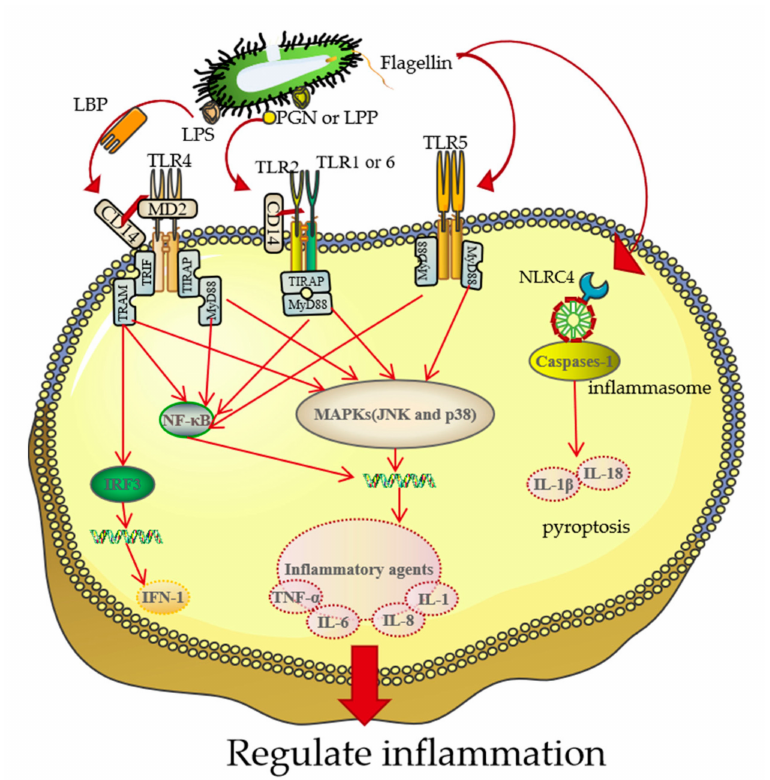
Figure 4. The pathway that mediates binding of BGs to TLRs on immune or epithelial cells. The cytoplasmic portion of TLR contains a Toll /IL-1 receptor homolog domain that induces the recruit- ment of various adapters such as MyD88, TRIF, TIRAP/MAL, and TRAM that regulates specific biological responses [57,58]. Membrane CD- 14 mediates binding between LPS on BGs with a TLR2 homologous dimer, activating the MyD88-independent pathway to produce IFN-1 [59]. CD-14 also mediates binding of surface LPP and PGN with TLR2/TLR6 or TLR2/TLR1 heterodimers, activating the MyD88-dependent pathway. The MyD88-independent and MyD88-dependent pathways even- tually stimulate the production of IFN-1 and NF- κ B, which activate the secretion of inflammatory factors such as IL-1 β , IL-8, and TNF- α [4]. These cytokines induce and regulate inflammation, recruit immune cells and induce apoptosis. In addition to activating the TLR5 pathway and the subsequent MAPK pathway, flagella can also activate NLRC4 inflammasome pathway in cells, which induces cell scorch